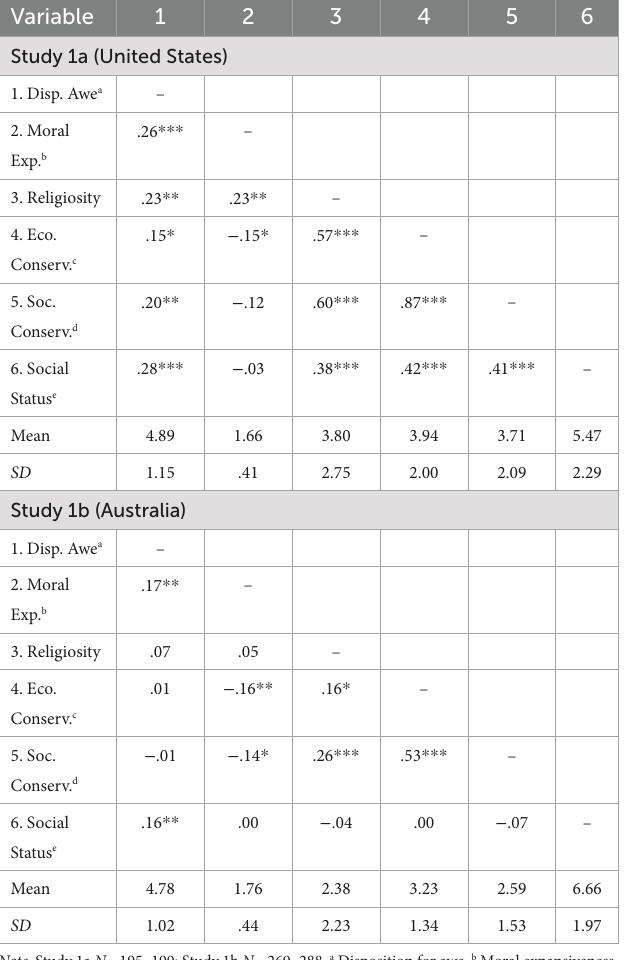
TABLE 1 Zero-order correlations between disposition for awe, moral expansiveness, and demographic variables in Studies 1a and 1b.